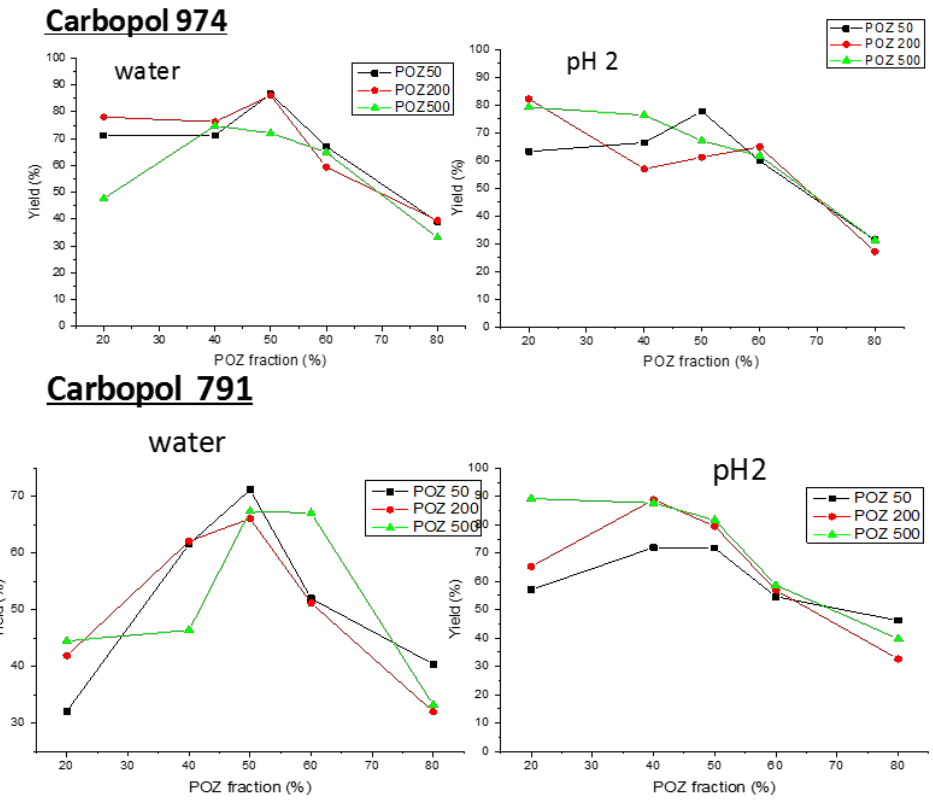
Figure 1. Yields of interpolymer complexes (wt %) for different Carbopol/poly(2-ethyl-2-oxazoline) systems in water and at pH 2.